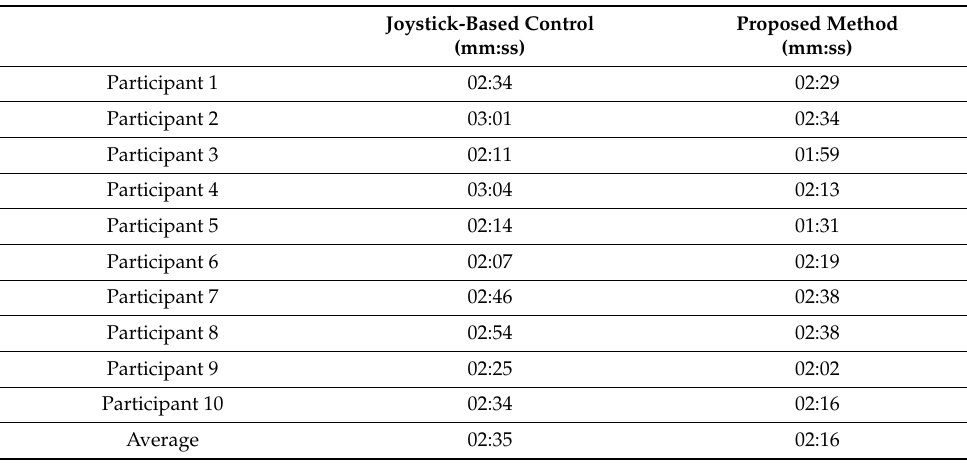
Table 6. Lap time comparison of joystick-based systems and proposed systems of 10 applicants according to a given